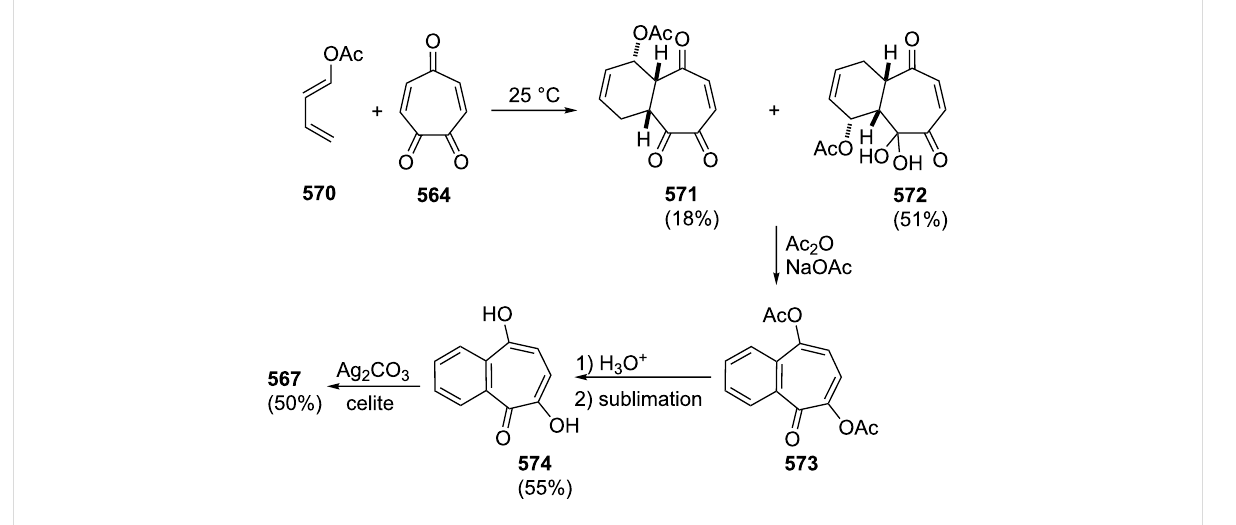
Scheme 103: Synthesis of benzotropoquinone 567 via a Diels–Alder reaction.